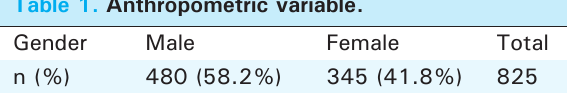
Table 1. Anthropometric variable.